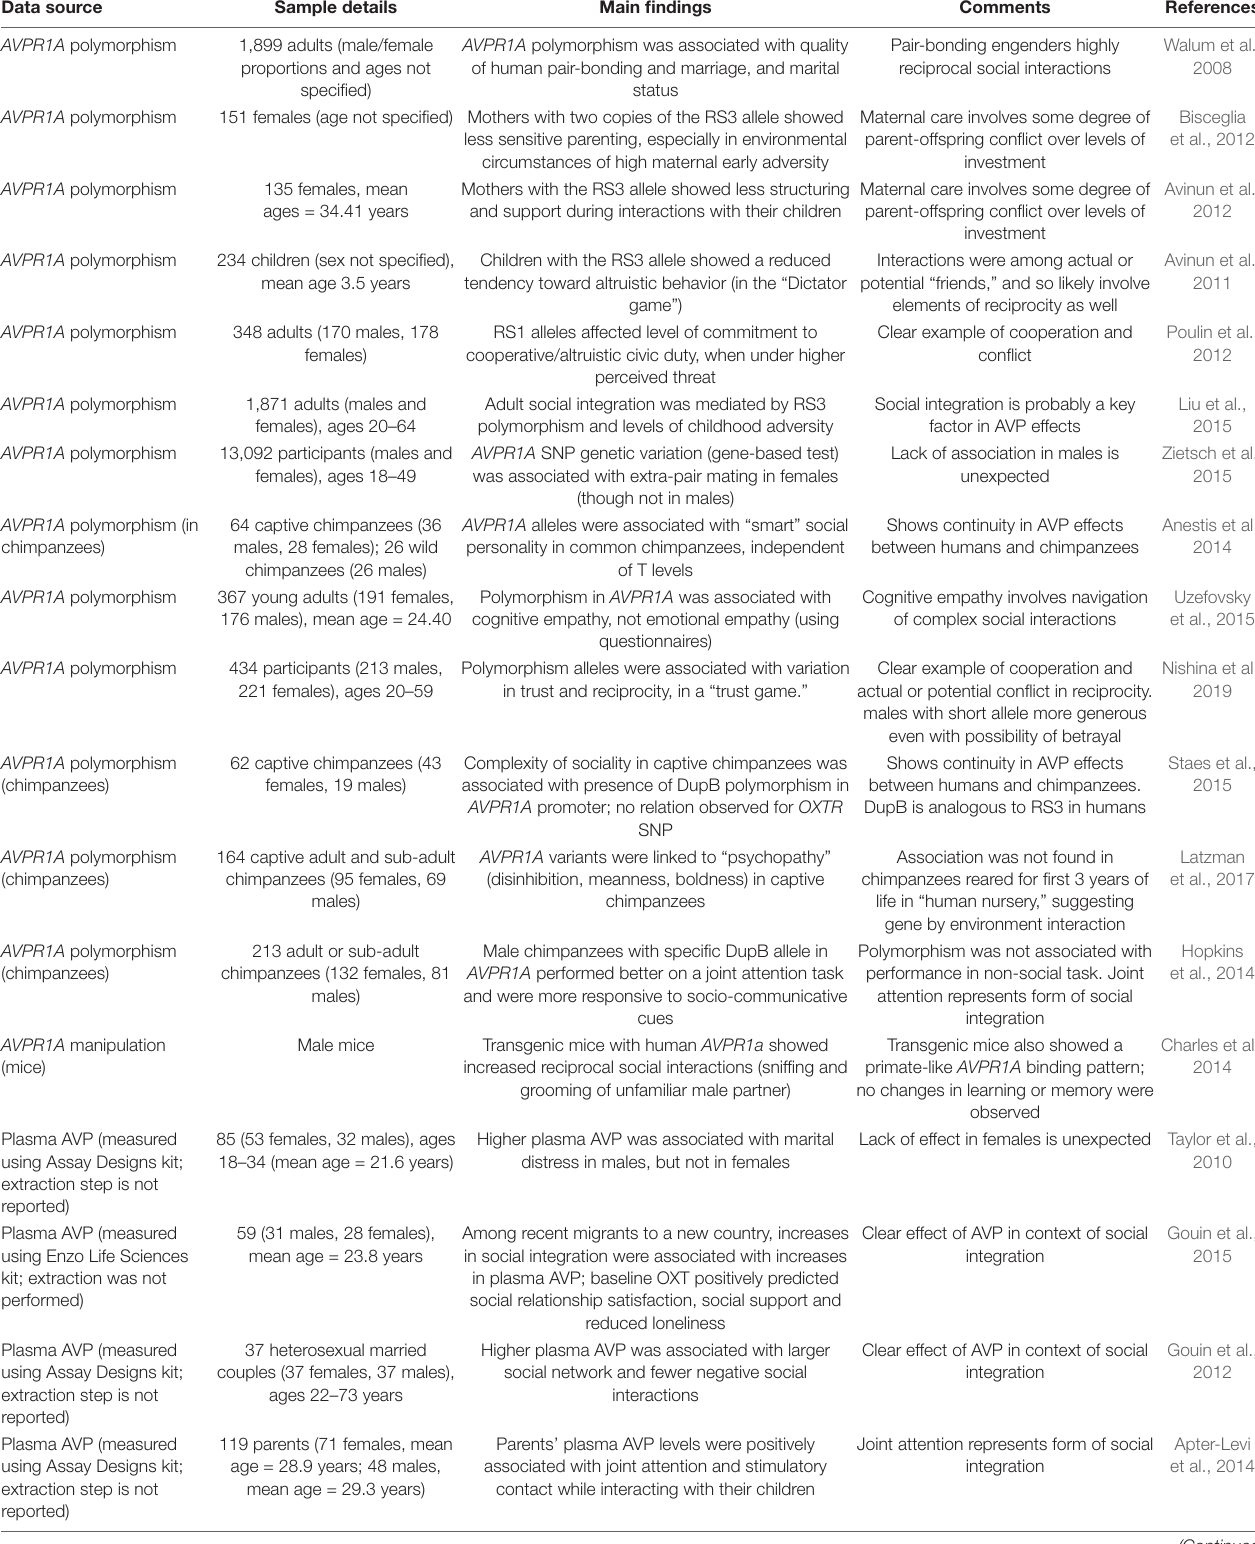
TABLE 1 | Findings salient to the hypothesis that AVP mediates affect, cognition, and behavior in situations involving a mixture of cooperation and